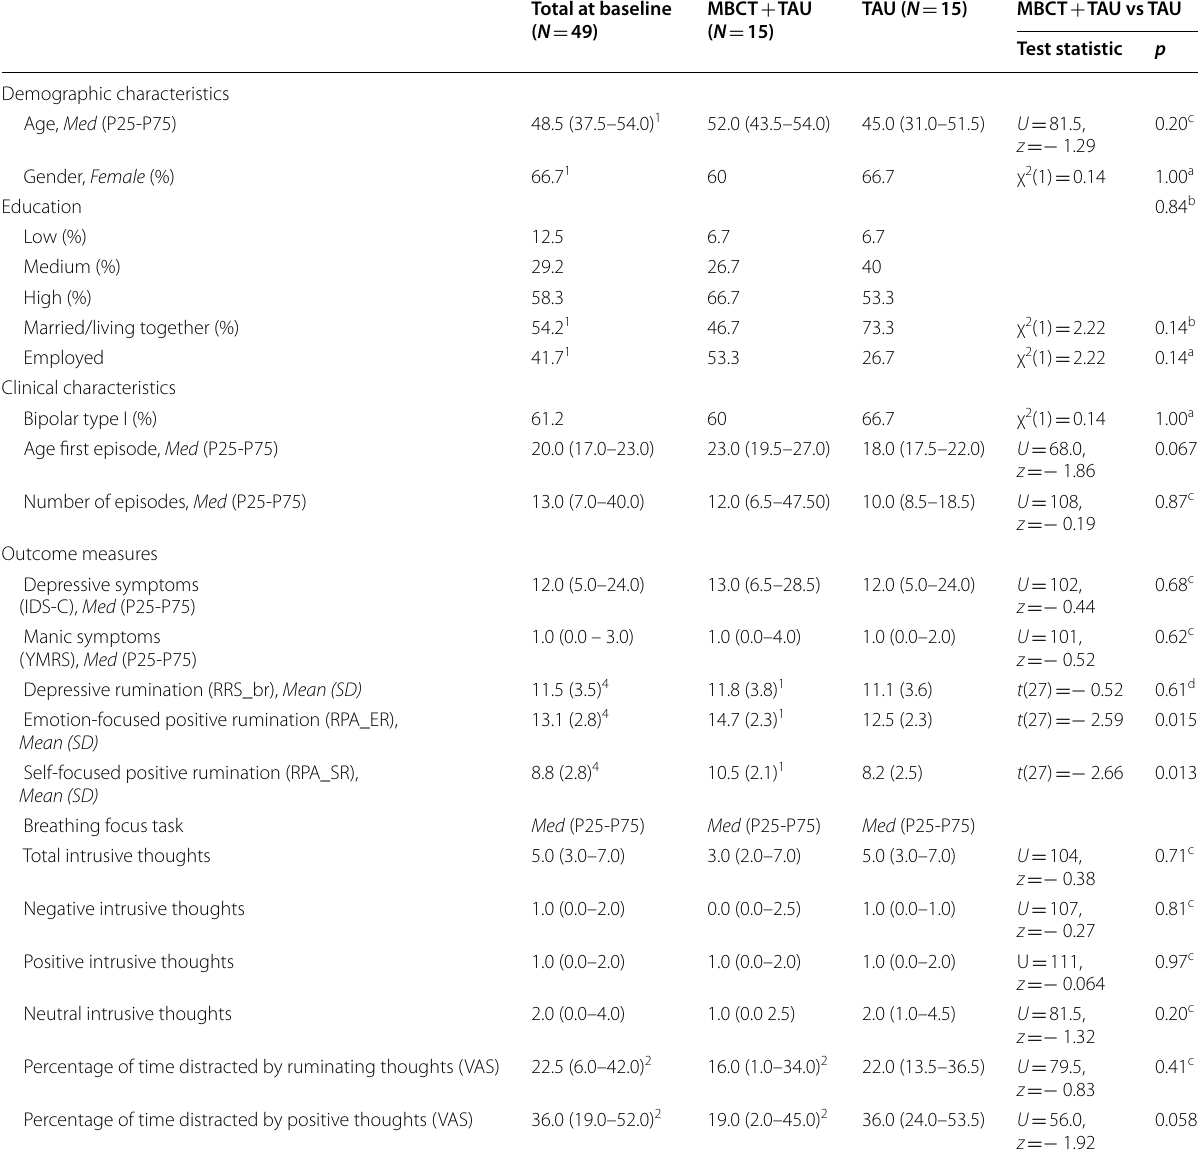
Table 1 Sociodemographic and clinical characteristics, and baseline outcome measures and the breathing focus task at